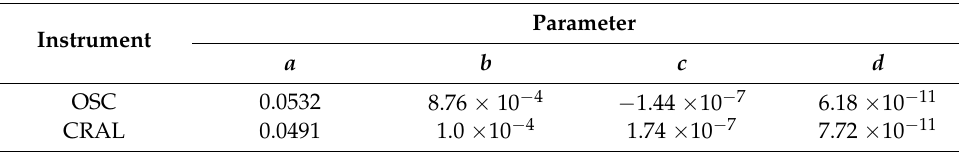
Figure 4. Calibration curves (black lines) and experimental data (black dots) of the generated drop volume as a function of the drop frequency for ( a ) the OSC gauge and ( b ) the CRAL gauge. Table 3. Parameters of the calibration curves for the two DC gauges.